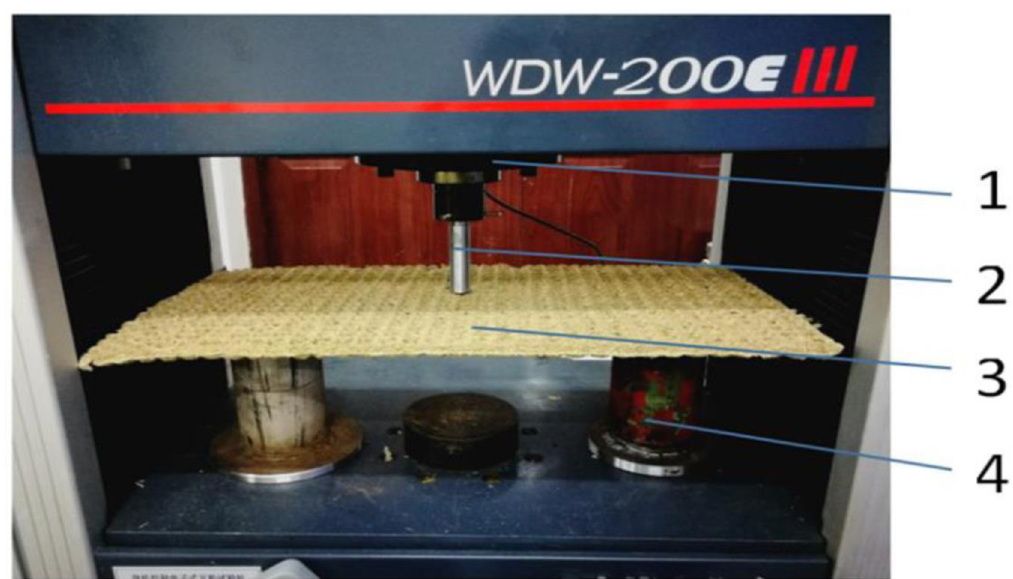
Fig 5. Test of anti destructive strength of rice straw bowl tray. 1. Platen 2. Pressure rod 3. Rice straw bowl tray 4. Support frame.